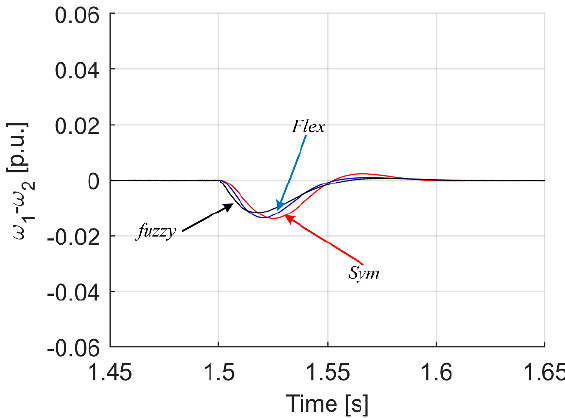
Figure 19. Transients of motor, load and reference speed for analyzed controller cases.